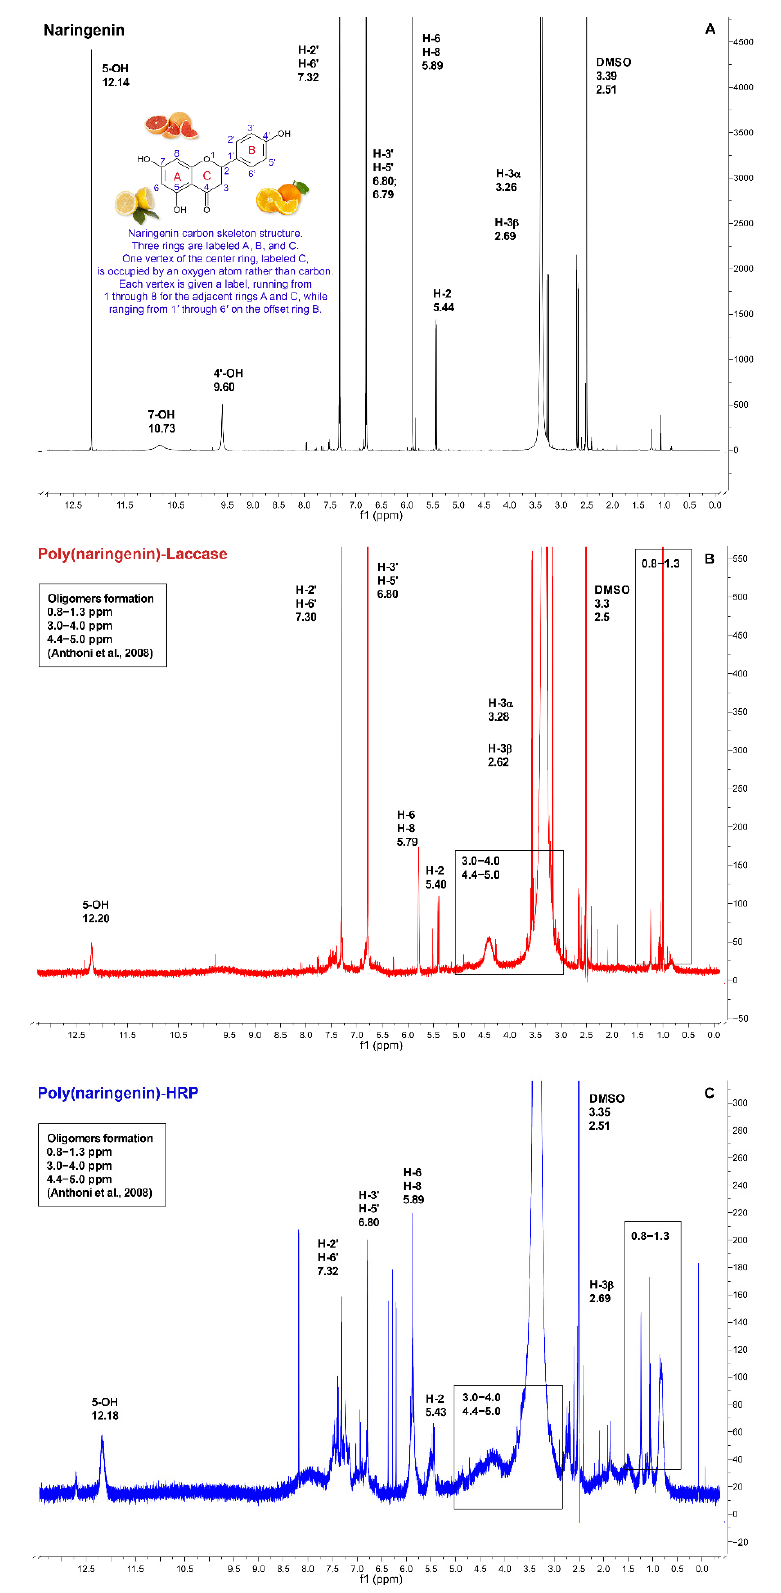
Figure 2. 1 H NMR of naringenin ( A ), poly(naringenin)-laccase ( B ) and poly(naringenin)-HRP ( C ), d6-DMSO, 250 MHz. According to Anthoni et al. [24] peaks in the ranges of 0.8–1.3 ppm, 3.0–4.0 ppm and 4.4–5.0 ppm were characteristic for the oligomeric formation of flavonoid.